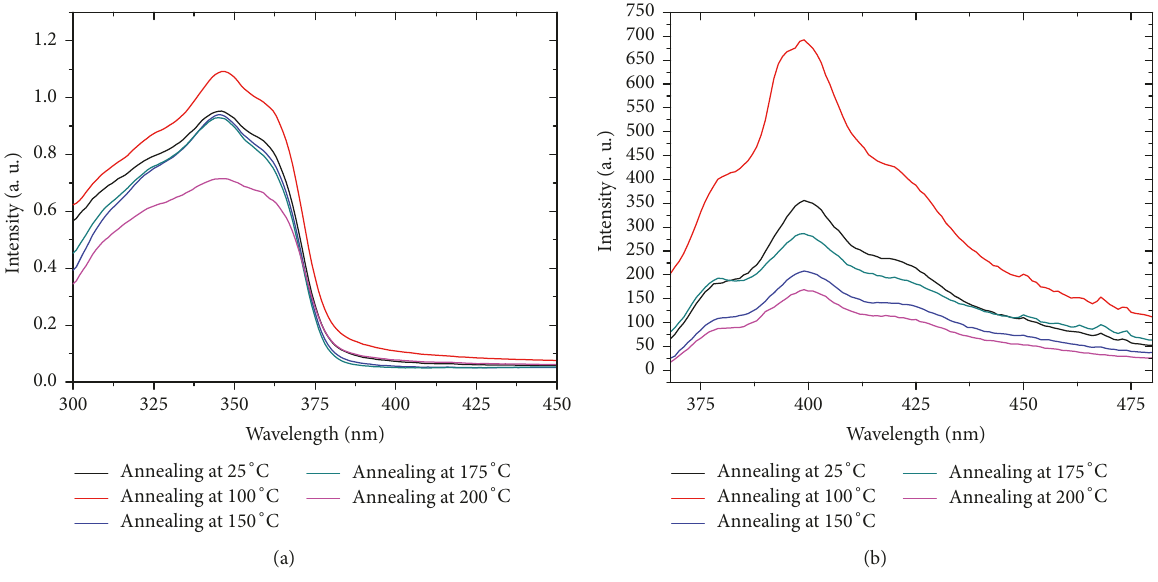
Figure 9: Absorption (a) and emission (b) of annealed samples of LaPPS71 ( 𝜆